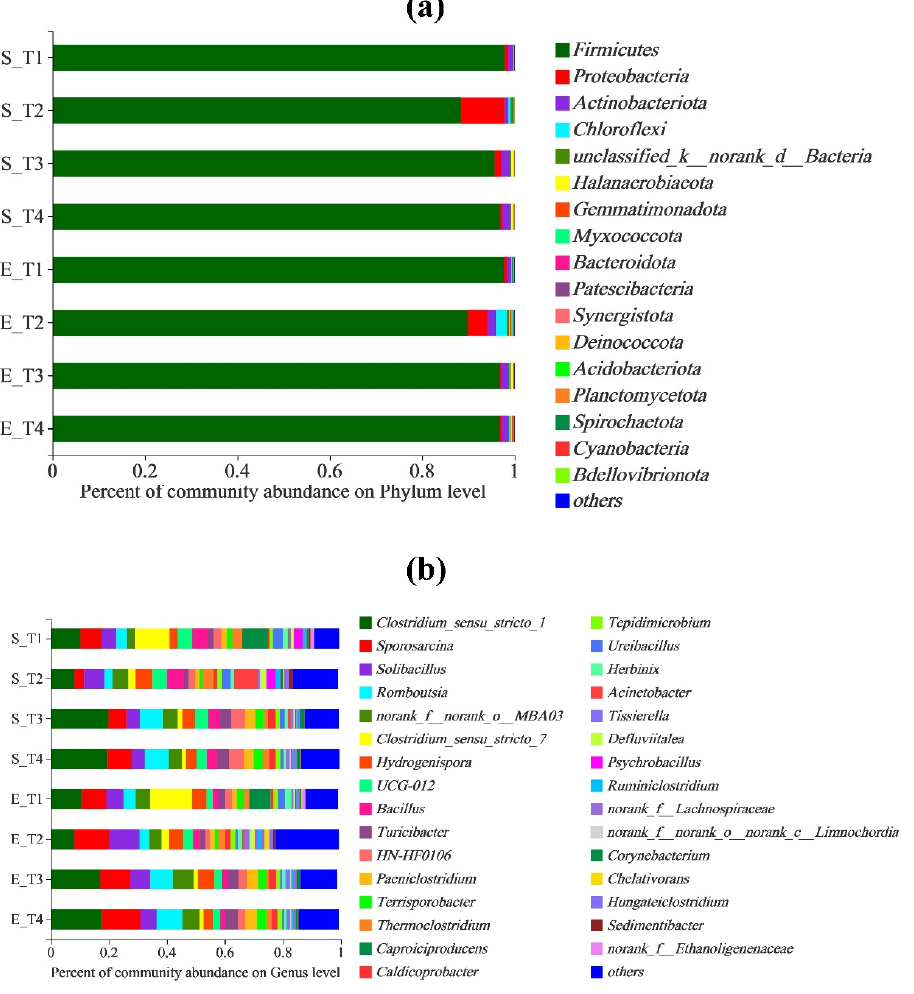
Figure 6. Analysis of bacterial community, based on ( a ) community structure on the phylum level, and ( b ) community structure on the genus level.